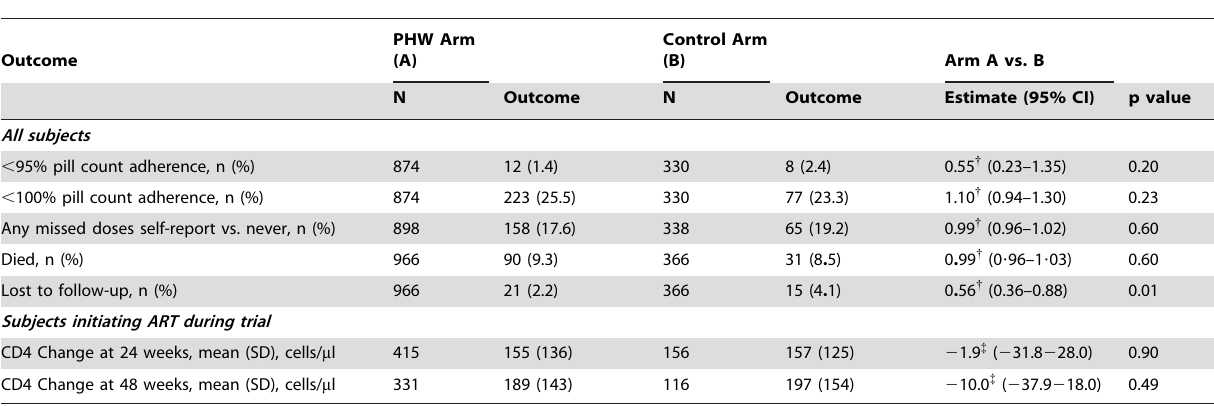
Table 3. Estimates of effect for non-virologic outcomes.*